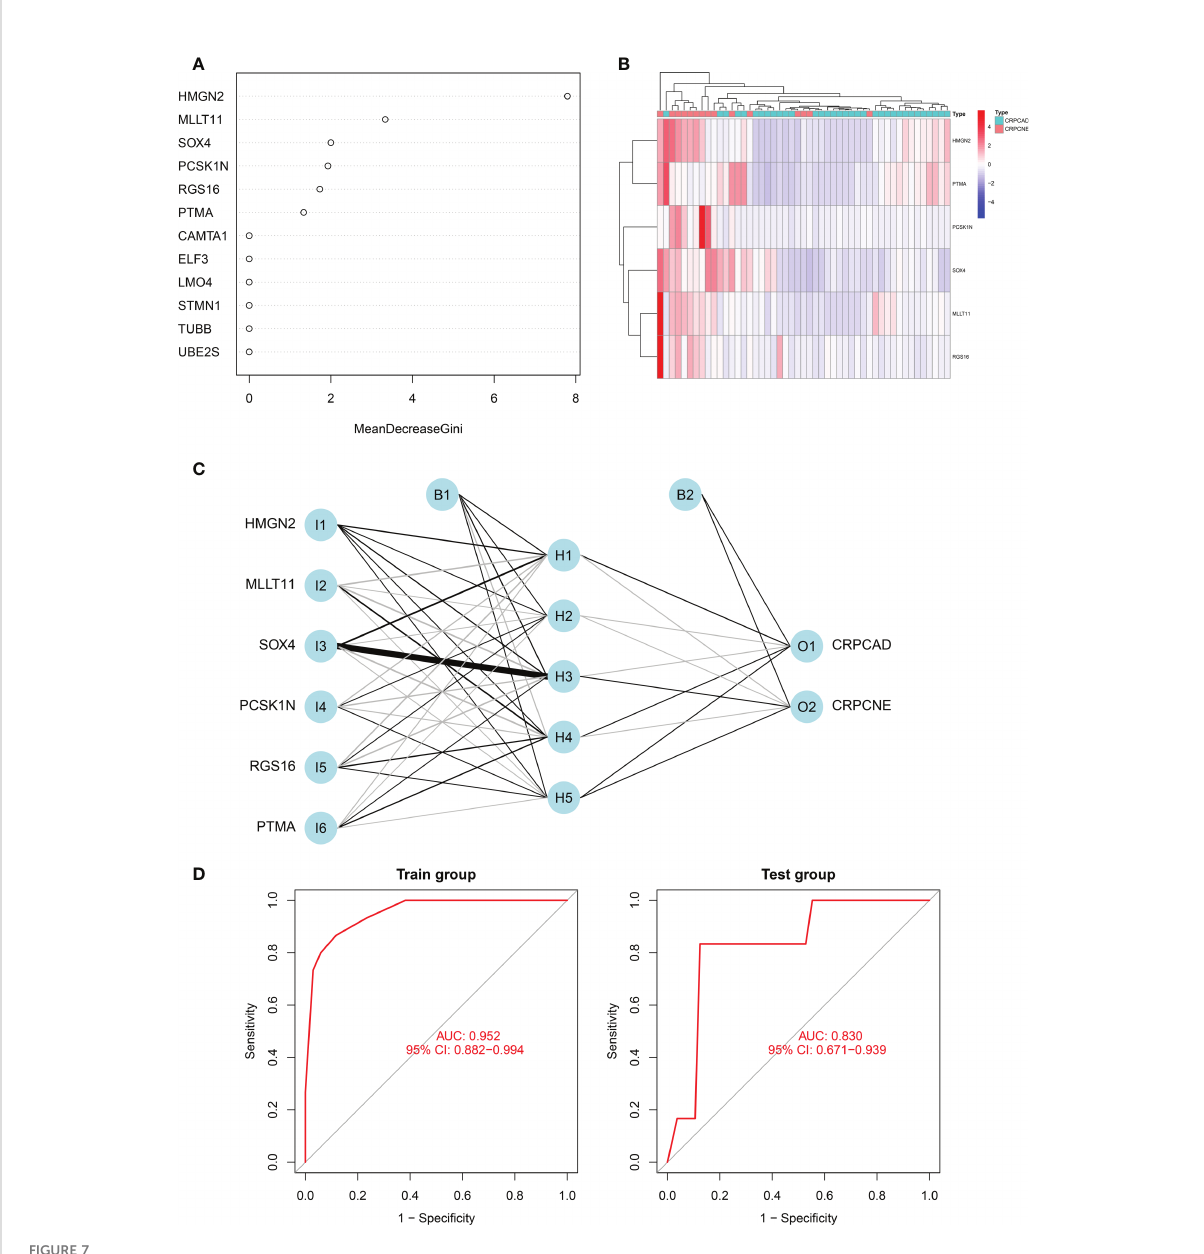
FIGURE 7 Identi fi cation of the markers to establish CRPC-NE diagnostic model. (A) The fi gure shows the weight of 12 genes to elucidate the importance of genes to disease classi fi cation (CRPC-NE or CRPC). The larger the ” MeanDecreaseGini ” index, the more likely this gene is to be classi fi ed as a characteristic gene. (B) Heatmap visualizing the expression levels of the six CRPC-NE diagnostic genes in the Cbioportal training cohort. (C) Results of neural network visualization: six CRPC-NE diagnostic genes were selected as the input nodes. Positive weights are connected by black lines, negative weights are connected by gray lines, and the thickness of the lines re fl ects the weight value. (D) The receiver operating characteristic (ROC) curves of 6-gene CRPC-NE diagnostic model in training cohort and validation